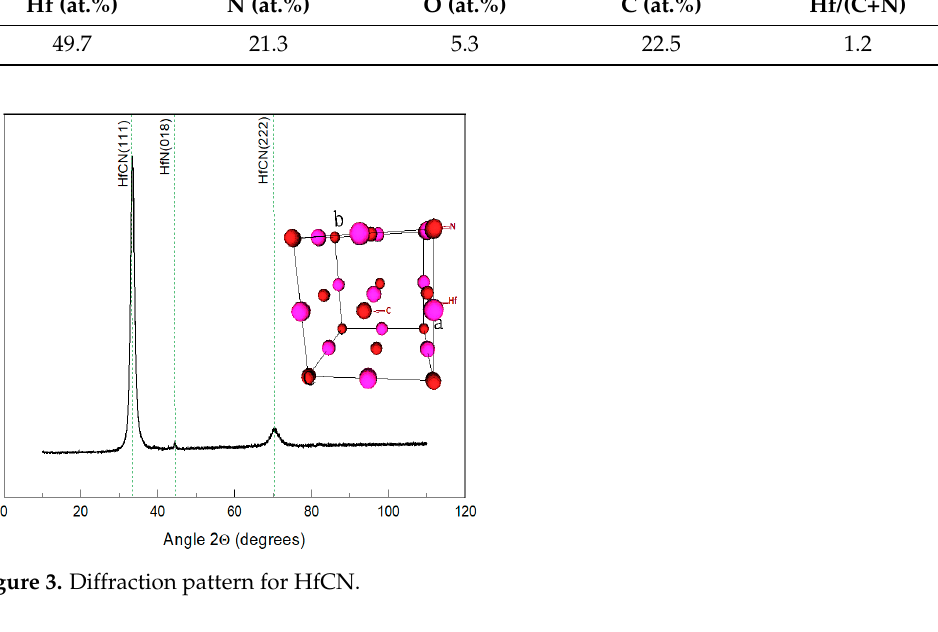
Figure 2. High resolution XPS spectra for the film grown at a bias voltage of − 150 volts: ( a ) Hf signal ( b ) C1s signal, ( c ) N1s signal. Table 2. Chemical compositions obtained from the XPS measurements. Hf (at.%) N (at.%)